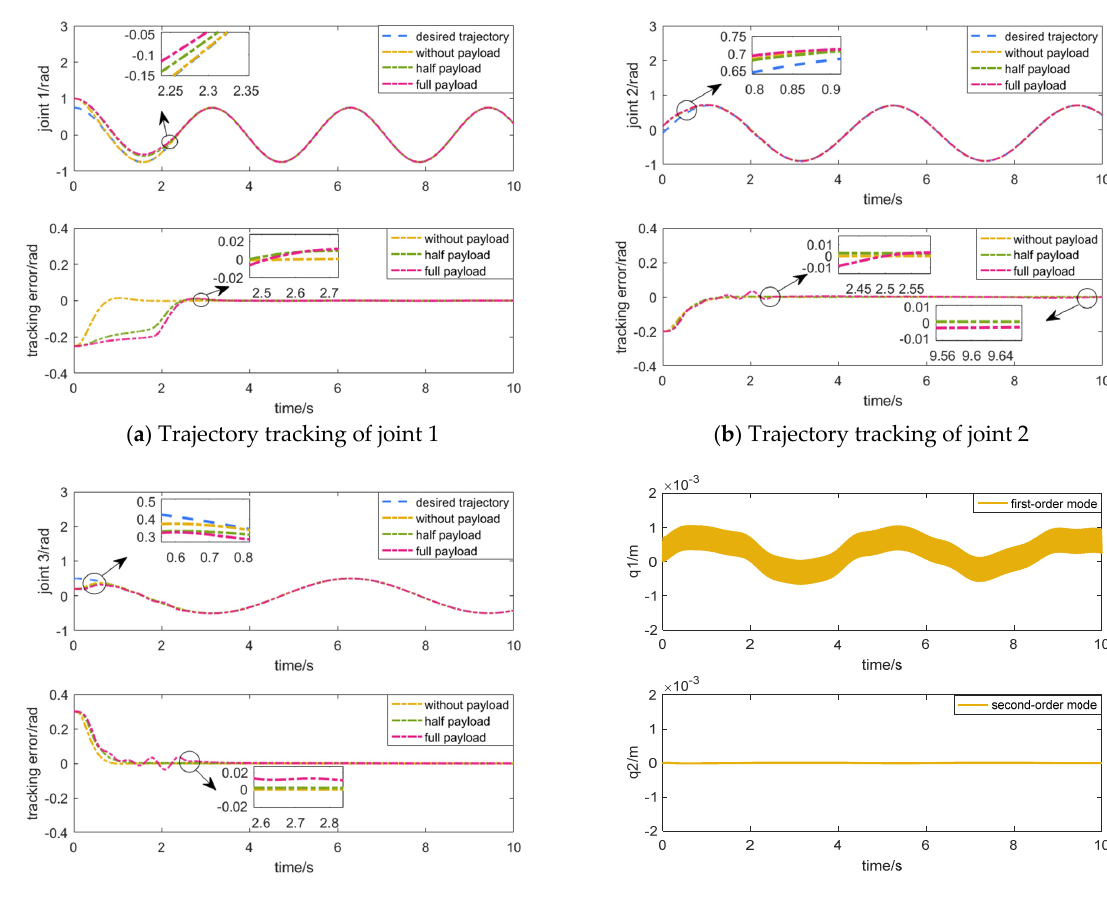
Figure 7. The structure of BP neural network.